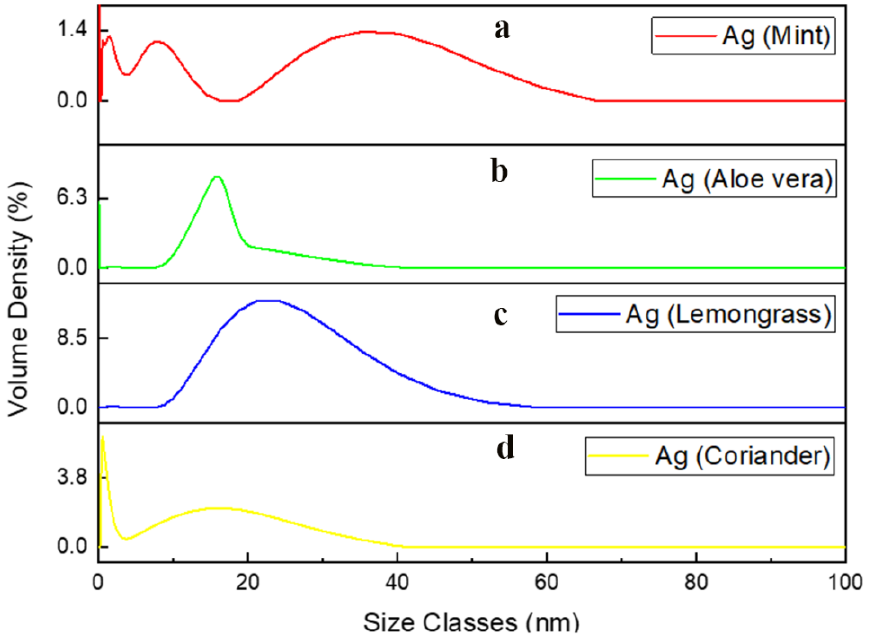
Figure 4. Particle size distribution of green synthesized Ag-NPs using plant extracts of ( a ) mint, ( b ) Aloe vera , ( c ) lemongrass, ( d ) coriander.